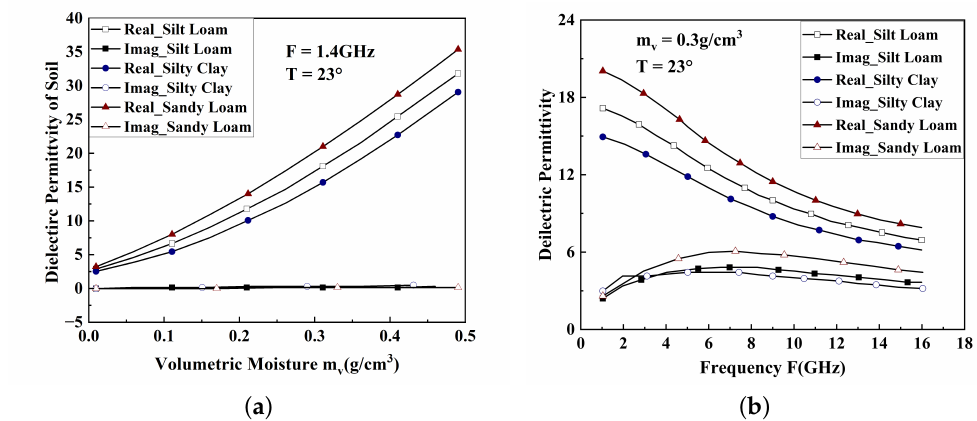
Figure 10. Dielectric permittivity of wet soil at different volumetric moisture or frequencies. ( a ) Di- electric constant vs. Volumetric Moisture. ( b ) Dielectric constant vs. frequency.